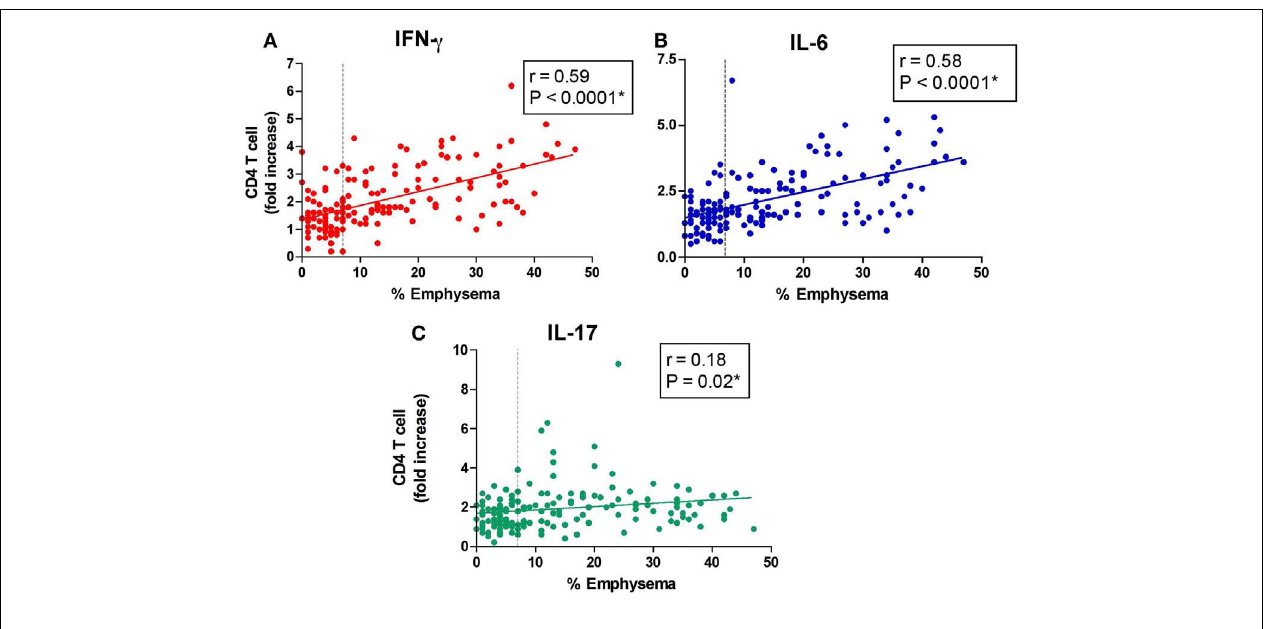
cells ( n = 156) in response to elastin fragments (EFs) compared to nil stimulation as described in Figure 1A . Dashed vertical line (7%) represents the upper limit of normal value for quantification of emphysema.